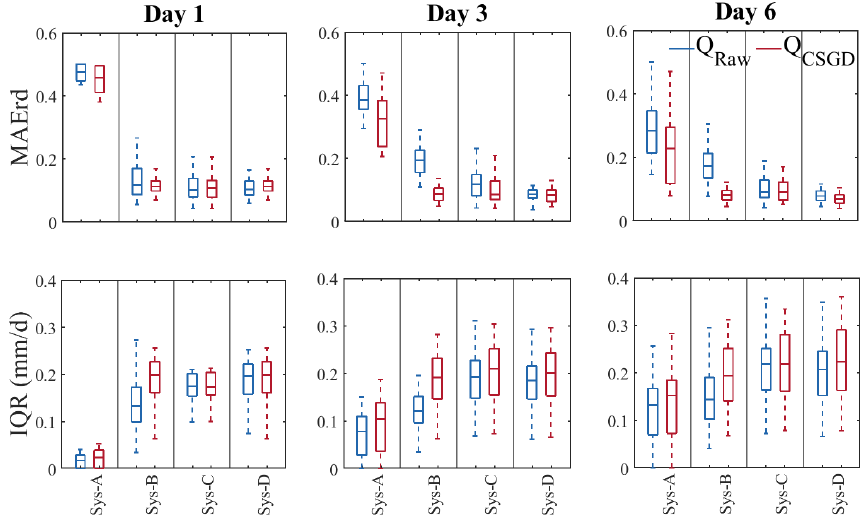
Figure 7. MAE of the reliability diagram (MAE rd ) and interquantile range (IQR) of the ensemble streamflow forecasts of the four hydrolog- ical prediction systems and lead times 1, 3, and 6d when considering raw (blue) and post-processed (red) precipitation forecasts. Box plots represent the score variability over the 30